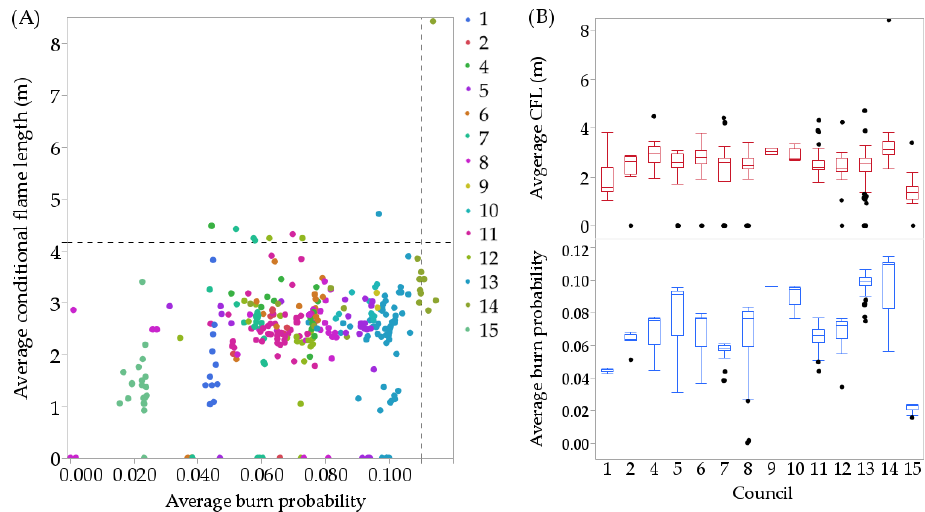
Figure 10. Individual residential house scatter ( A ) and box plots ( B ) for the different councils in the study area. Each point in the scatterplot indicates the average value of burn probability (BP) and conditional flame length (CFL) within the home ignition zone for a single structure. The bubble color indicates the council (Figure 1A), and the dotted lines the 97th percentile values of 0.11 for BP and 4.16 m for CFL. In the box plots, the boxes indicate the first/third quartiles, the whiskers indicate 10th/90th percentiles, the horizontal line within the box is the median, and the black dots indicate values below the 10th percentile or above the 90th percentile.